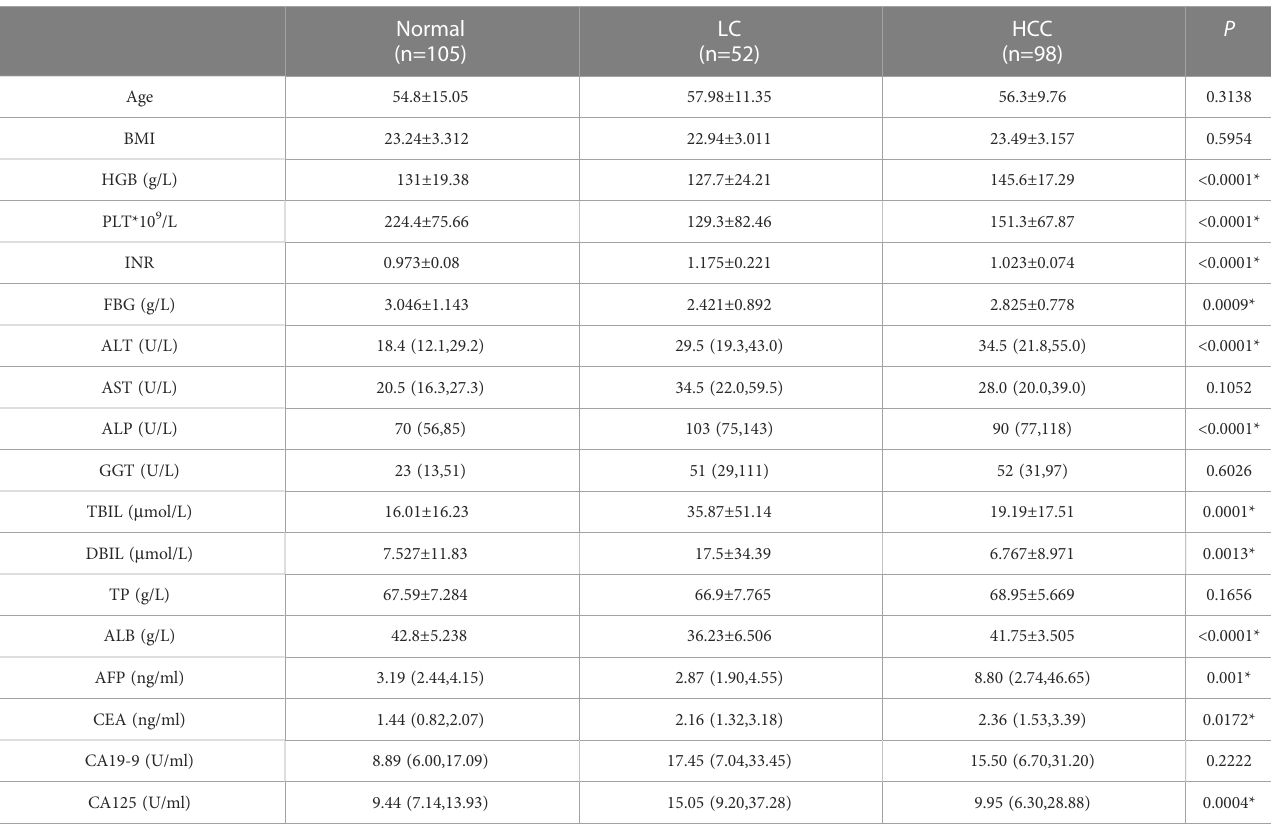
TABLE 3 Demographic and laboratory data of all studied